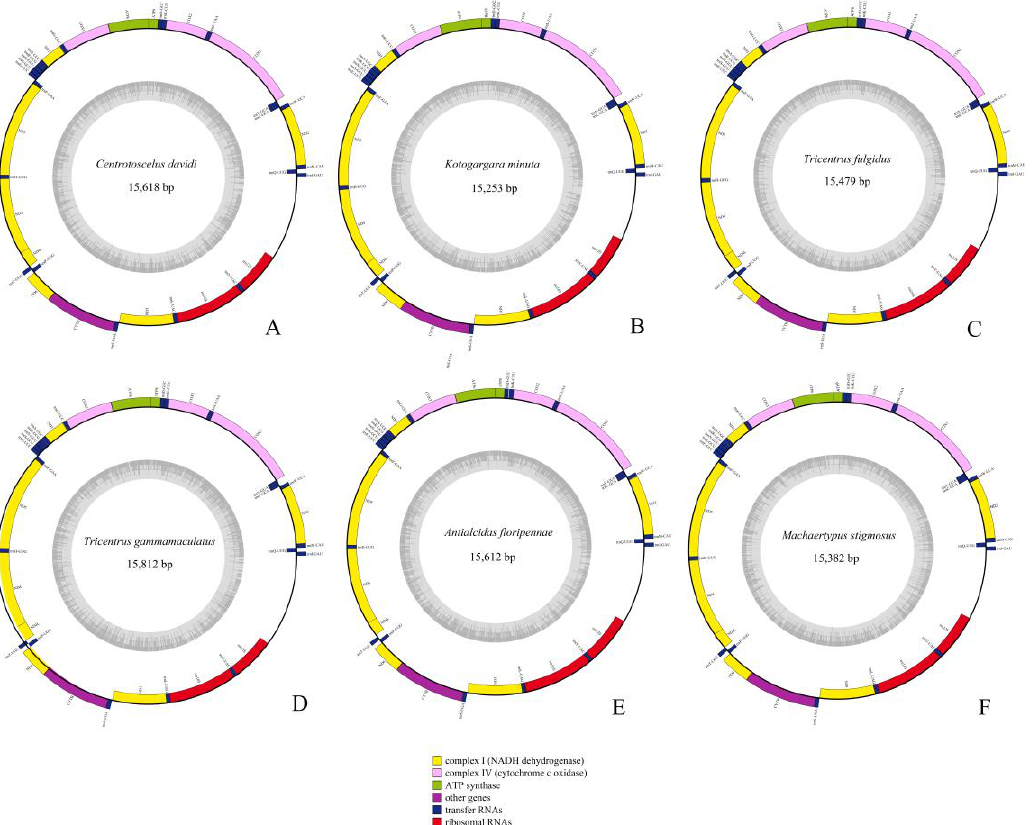
Figure 2. Circular maps of the mitogenomes of Gargarini. ( A ) Centrotoscelus davidi , ( B ) Kotogargara minuta , ( C ) Tricentrus fulgidus , ( D ) Tricentrus gammamaculatus , ( E ) Antialcidas floripennae , ( F ) Machaerotypus stigmosus . Color blocks outside the circle indicate that the genes are on the majority strand (J-strand); those within the circle indicate the genes are located on the minority strand (N-strand).